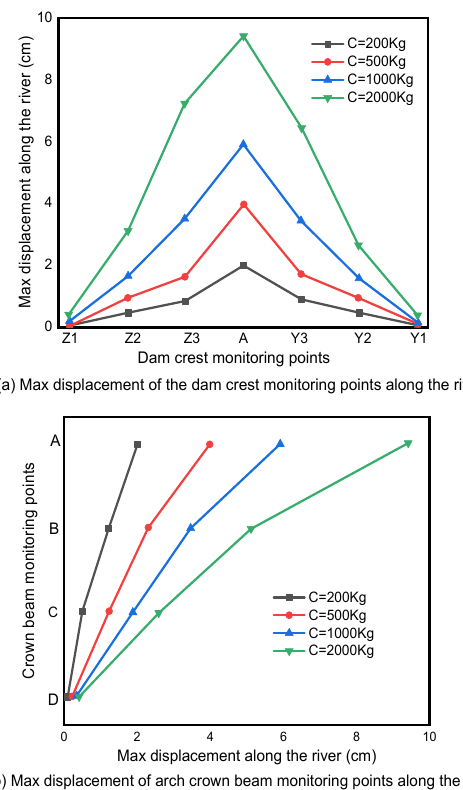
Figure 11. Dam crest damage curve with different explosive charges. The maximum values of displacement, velocity, and acceleration of each monitoring point at the dam crest and arch crown cantilever in the entire dynamic time history are extracted to further study the dynamic response of the dam body under different explosive equivalents, as shown in Figure 12. When the explosive weight is 5000 kg, almost all of the dam crest positions are damaged, and some of them are blown up, causing their displacement to increase indefinitely. As a result, 5000 kg of TNT is not included in the figure.